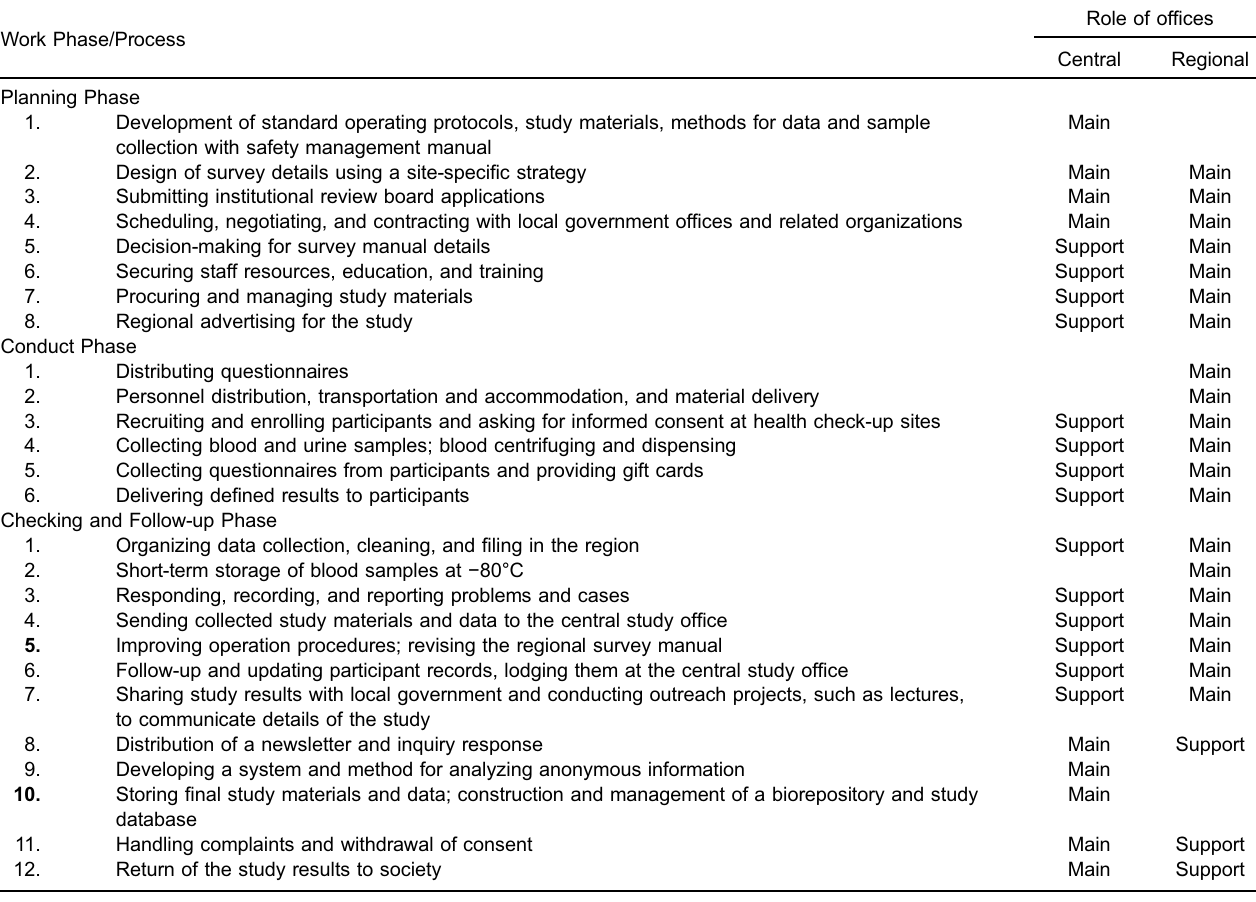
Table 2. Work process and role of study of fi ces in the standard protocol Work